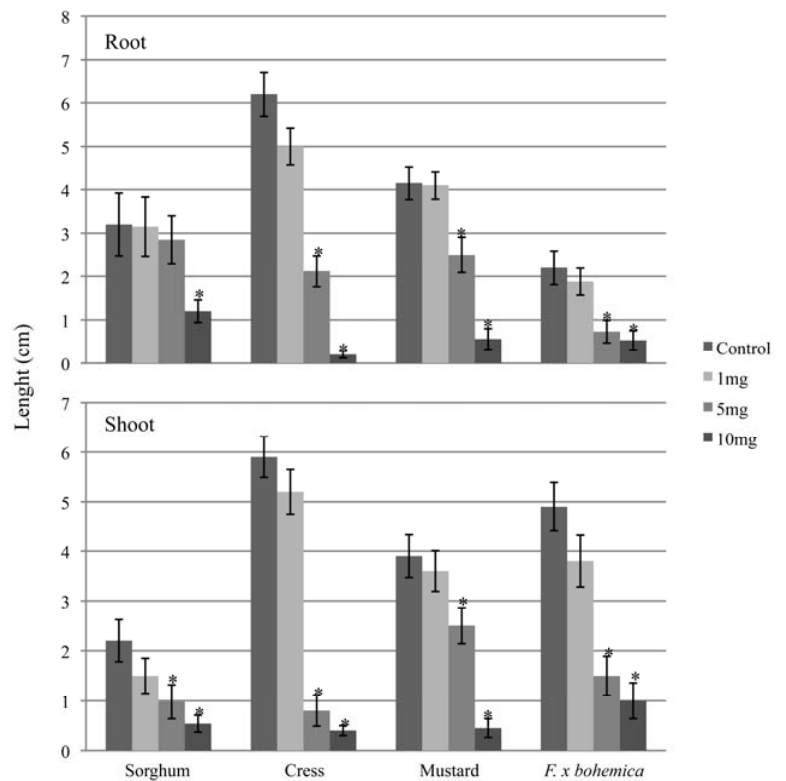
Figure 1. The effects of M. gale fruit exudate extracts on the root and shoot growths of sorghum, cress, mustard and F. x bohemica . Concentrations are the total quantities of dry exudate extracts added to each Petri dish for the bioassays. Means ± SE are shown for three independent experiments with 5–10 plants per treatment. Significant differences with the control treatment ( P < 0.05, Tukey’s test) are indicated by